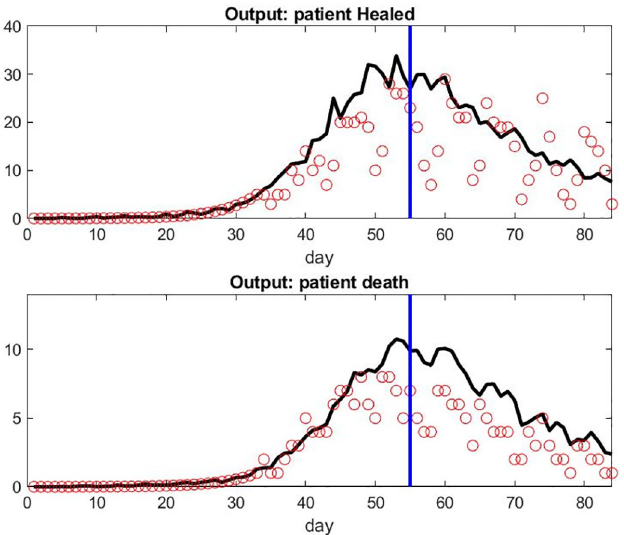
Fig 15. Top: Predicted Number of Patient Healed Leaving Hospital in France per Day on the right of the blue line. Bottom: Predicted Number of Death per Day in France per day on the right of the vertical blue line.